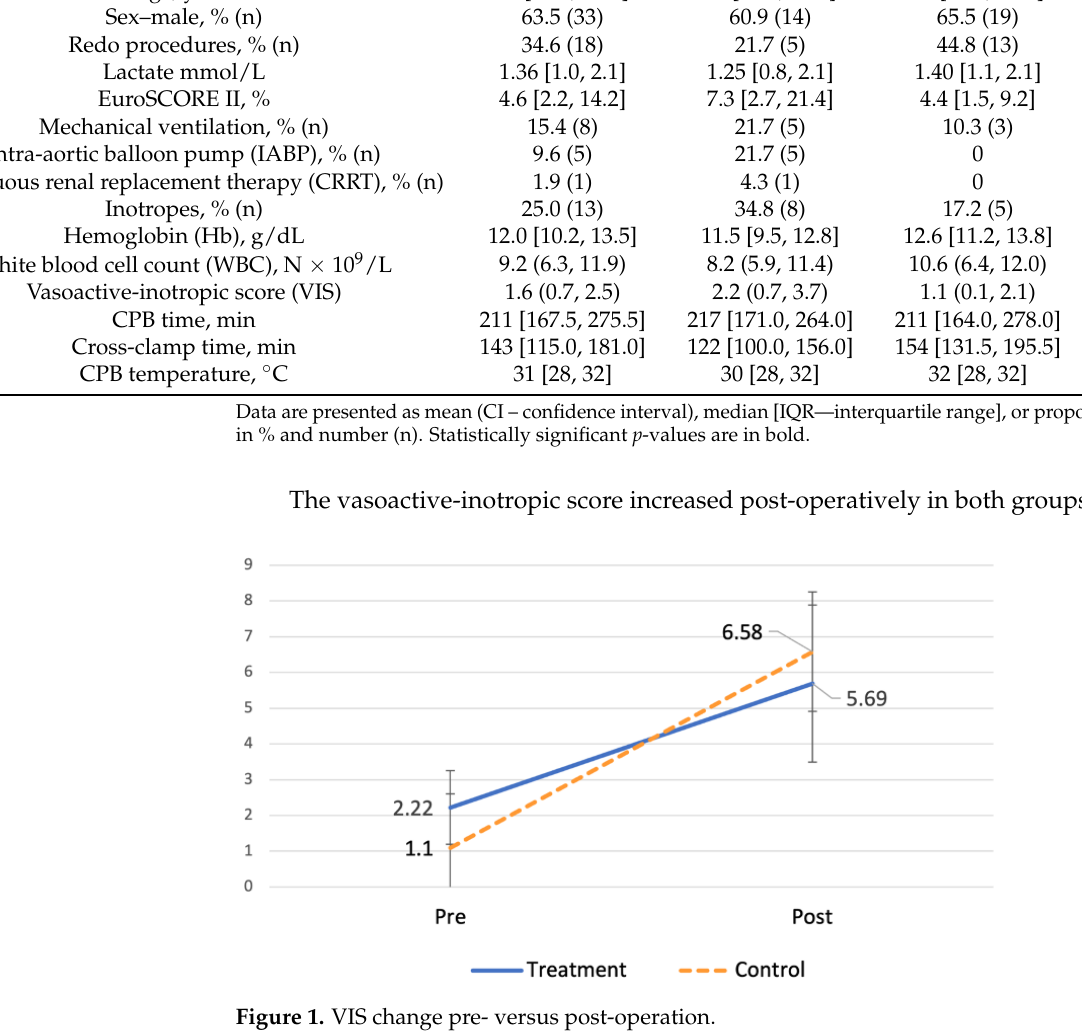
Table 1. Baseline characteristics.